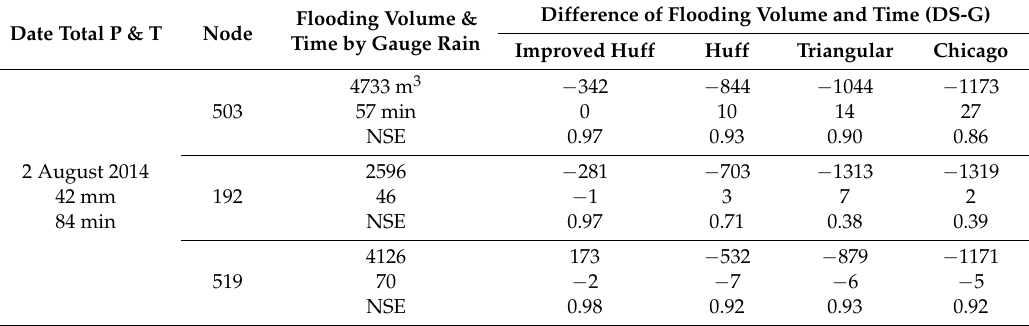
Figure 6. Comparisons of hyetographs ( a ) and the according ground measured and simulated flooding volume by SWMM using different hyetographs at Node 503 ( b ), Node 192 ( c ) and Node 519 ( d ) for the storm event recorded at Site 4 on 2 August 2014, with total rainfall of 42 mm and duration of 84 min. Table 8. Peak flooding volume, time, and NSE simulated by SWMM using rainfall depths from gauge observations at Sites 4 and the considered design storms. The last four columns are the difference in the simulated peak flooding volume and time using design storms (DS) against those by gauge (G) rainfall depth. The water volume at Node 503 is computed according to the DEM and water depth recorded at Site 4/Node 503, while that at Node 192 and 519 is simulated by SWMM using gauge rainfall depth data at Site 4.